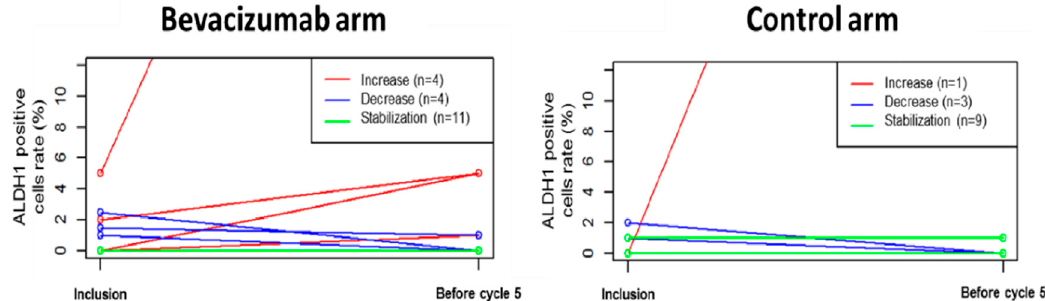
Figure 2. ADLH1 positive cells rates modifications after the first four cycles of treatment (each line represents one patient). Red lines represent patients presenting an increase of ALDH1+ cells rate. Blue lines represent patients presenting a decrease of ALDH1+ cells rate. Green lines represent patients without ALDH1+ cells rate modification.